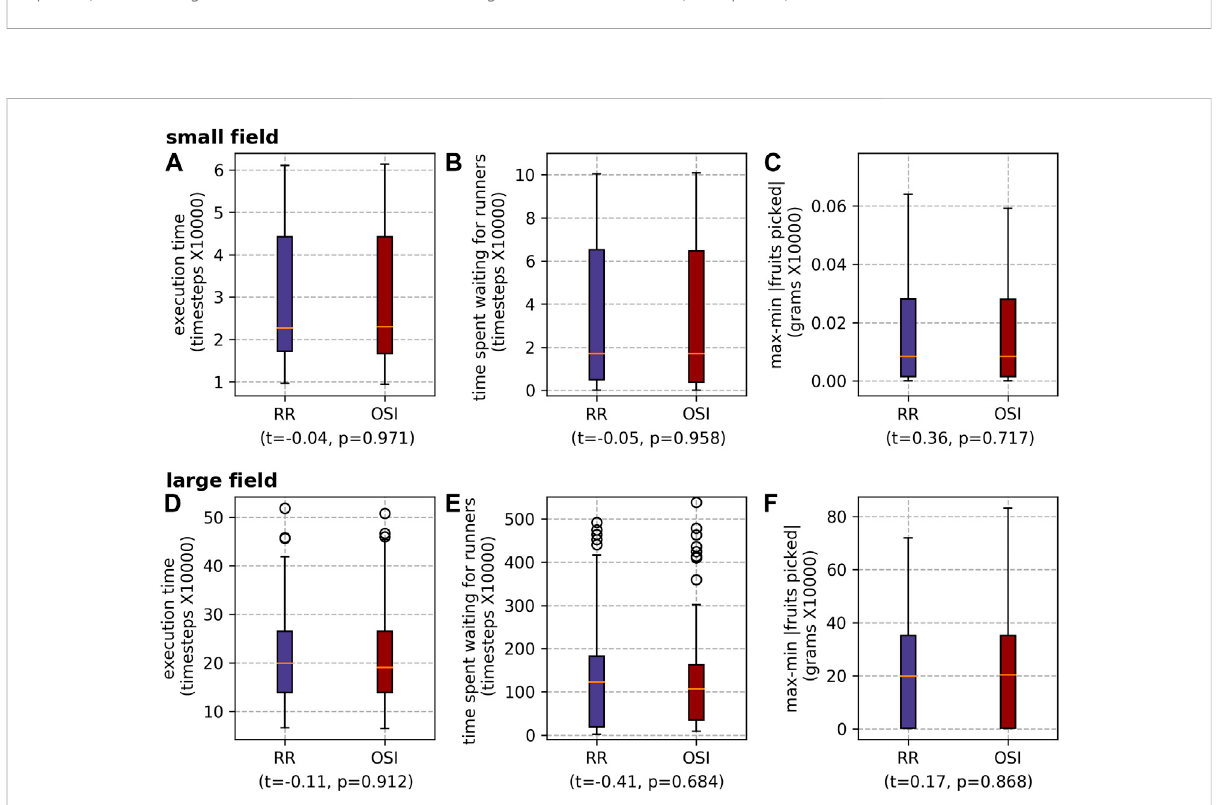
FIGURE 12 Results for the different runner scheduling mechanisms for both farms: the small fi eld (A) execution time, (B) waiting time and (C) max-min | fruits picked|; and the large fi eld (D) execution time, (E) waiting time and (F) max-min |fruits picked|.